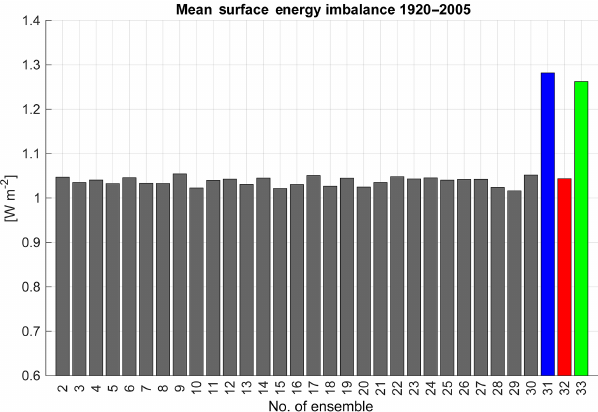
Figure 5. Mean surface energy imbalance from 1920 to 2005 for CESM-LE members 2–30 and new members 31–33. Note that members 31 and 33 have been subjected to lossy compression.